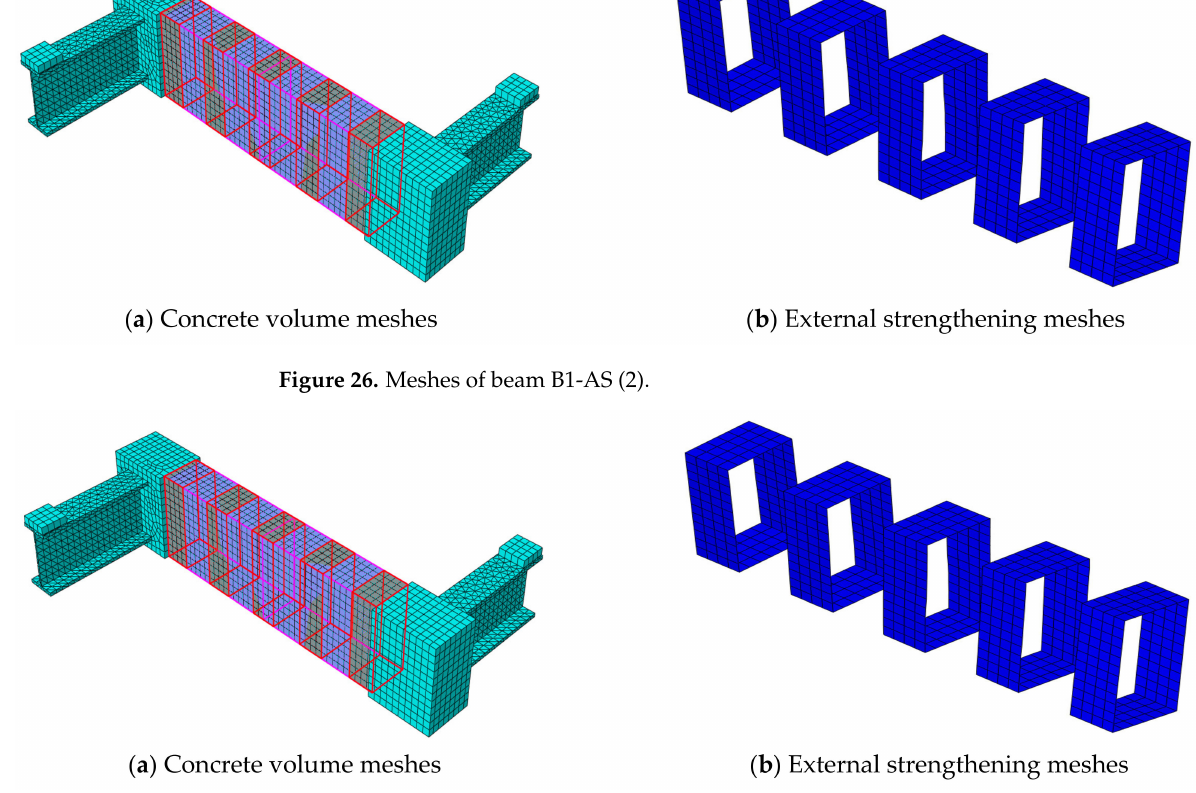
Figure 27. Meshes of beam B2-SS.